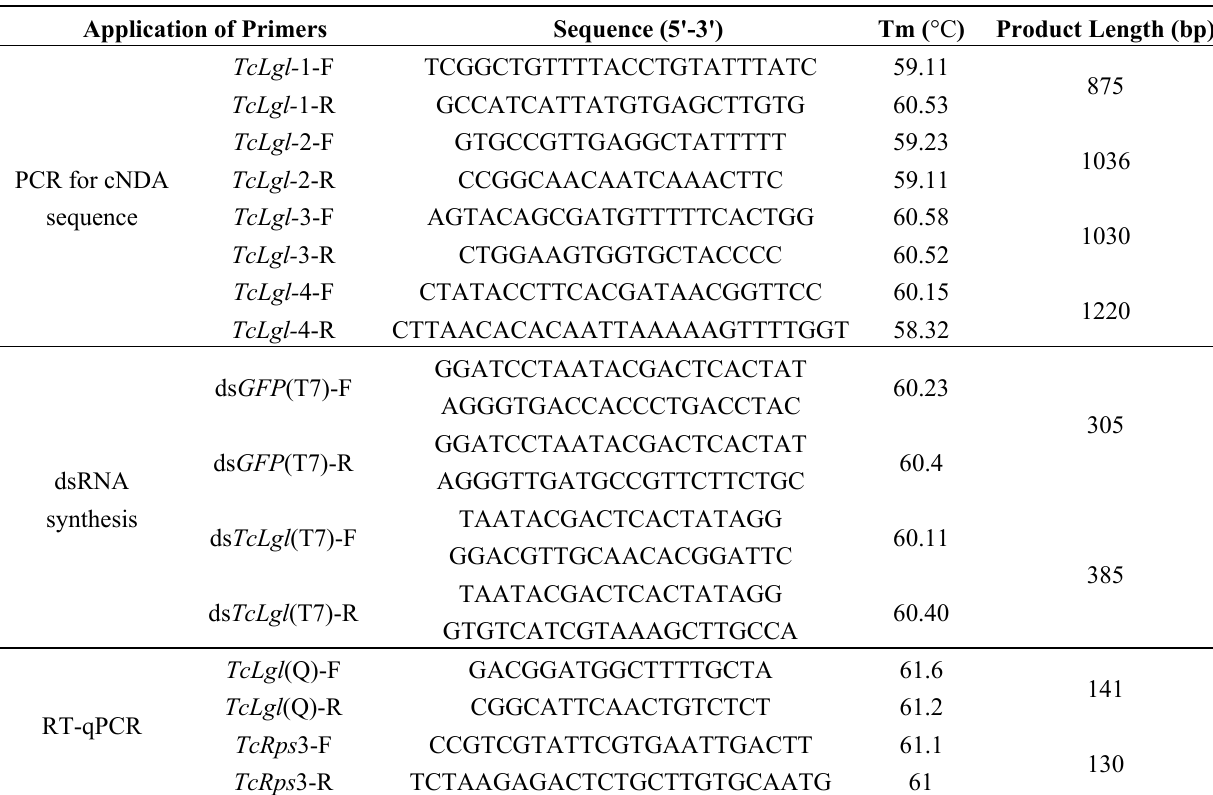
Table 1. Primers used to amplify TcLgl cDNA sequences, synthesize dsRNA and analyze transcript